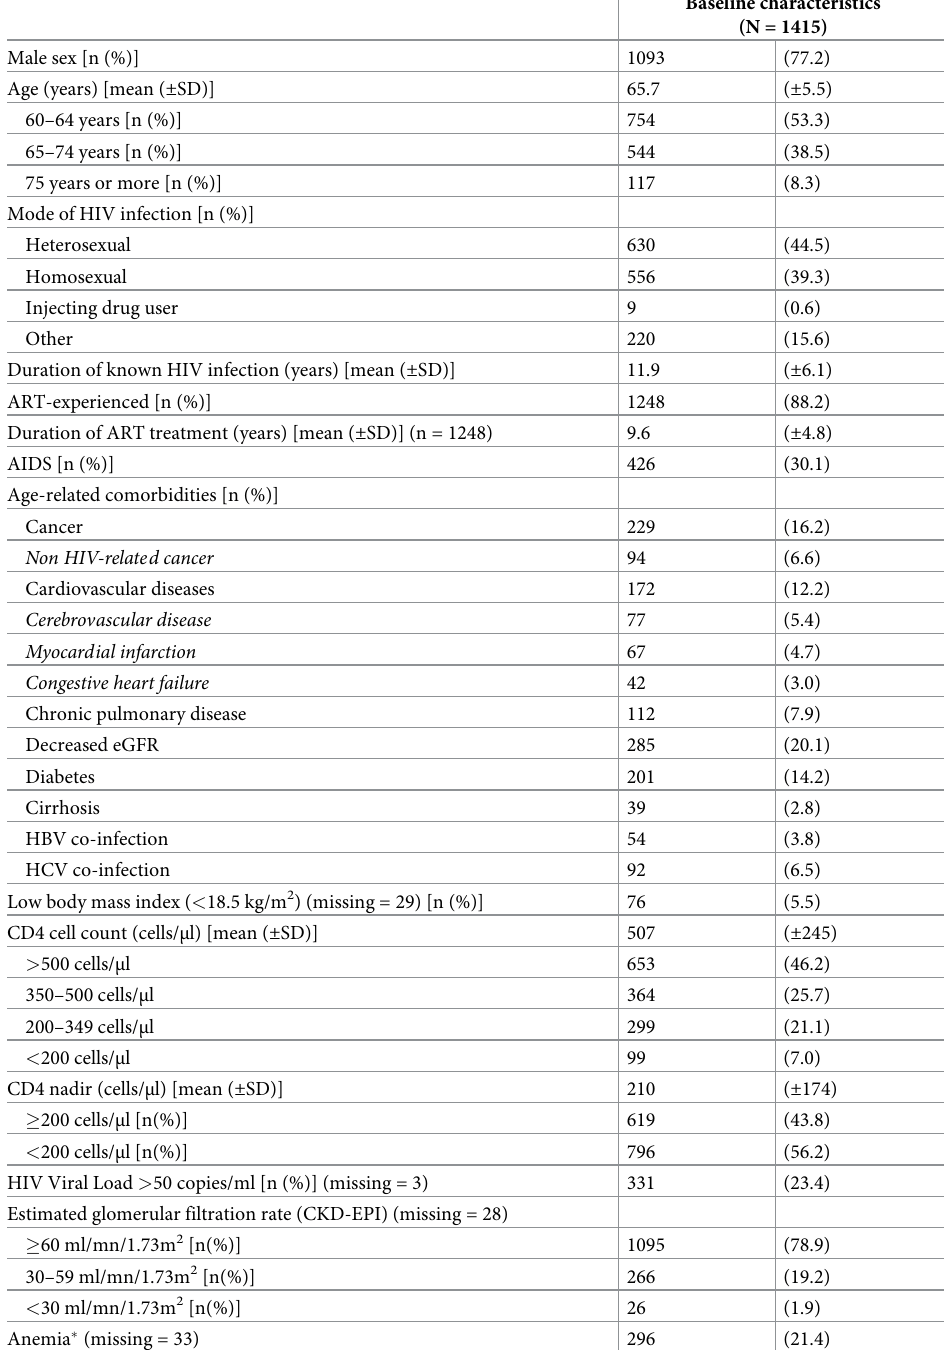
Table 1. Baseline characteristics of the 1,415 PLHIV aged 60 years or more from the Dat’AIDS